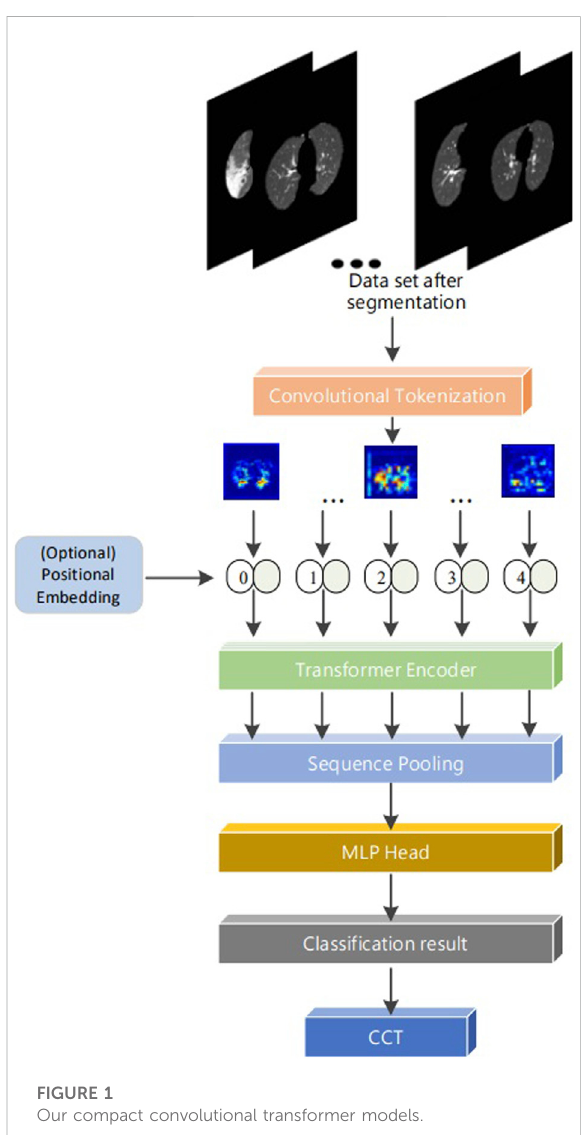
FIGURE 1 Our compact convolutional transformer models.